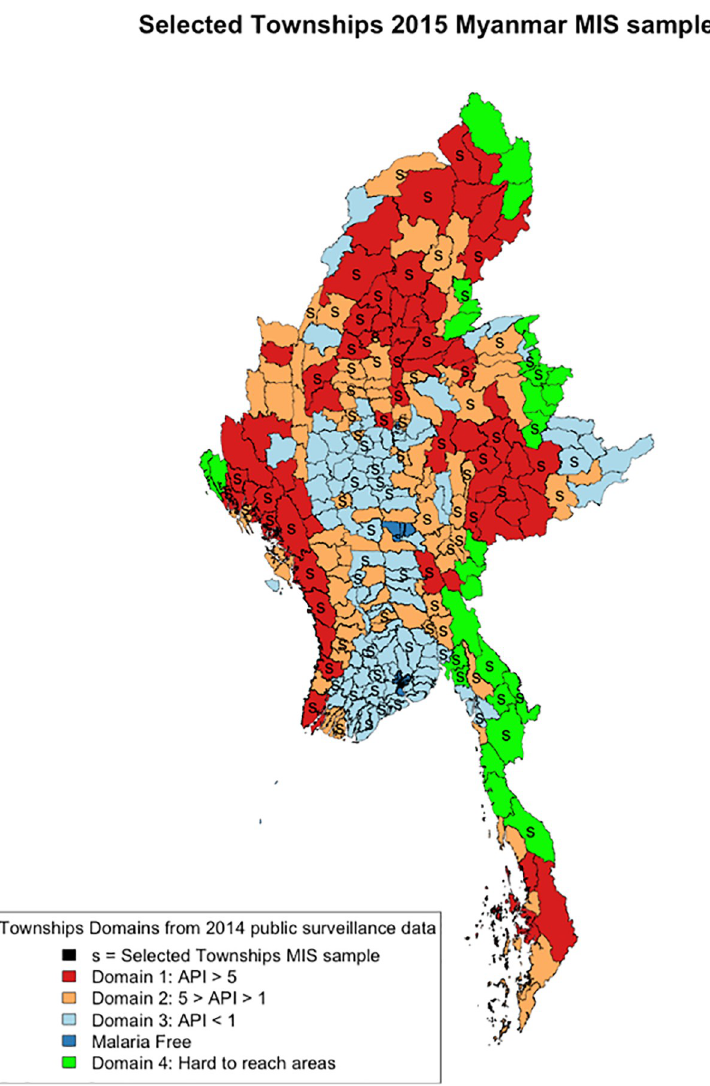
Fig 1. Map of Myanmar showing location of the four sampling domains. Domain 1: API > 5; Domain 2: API 1–5; Domain 3: API < 1; Domain 4: non-state areas.